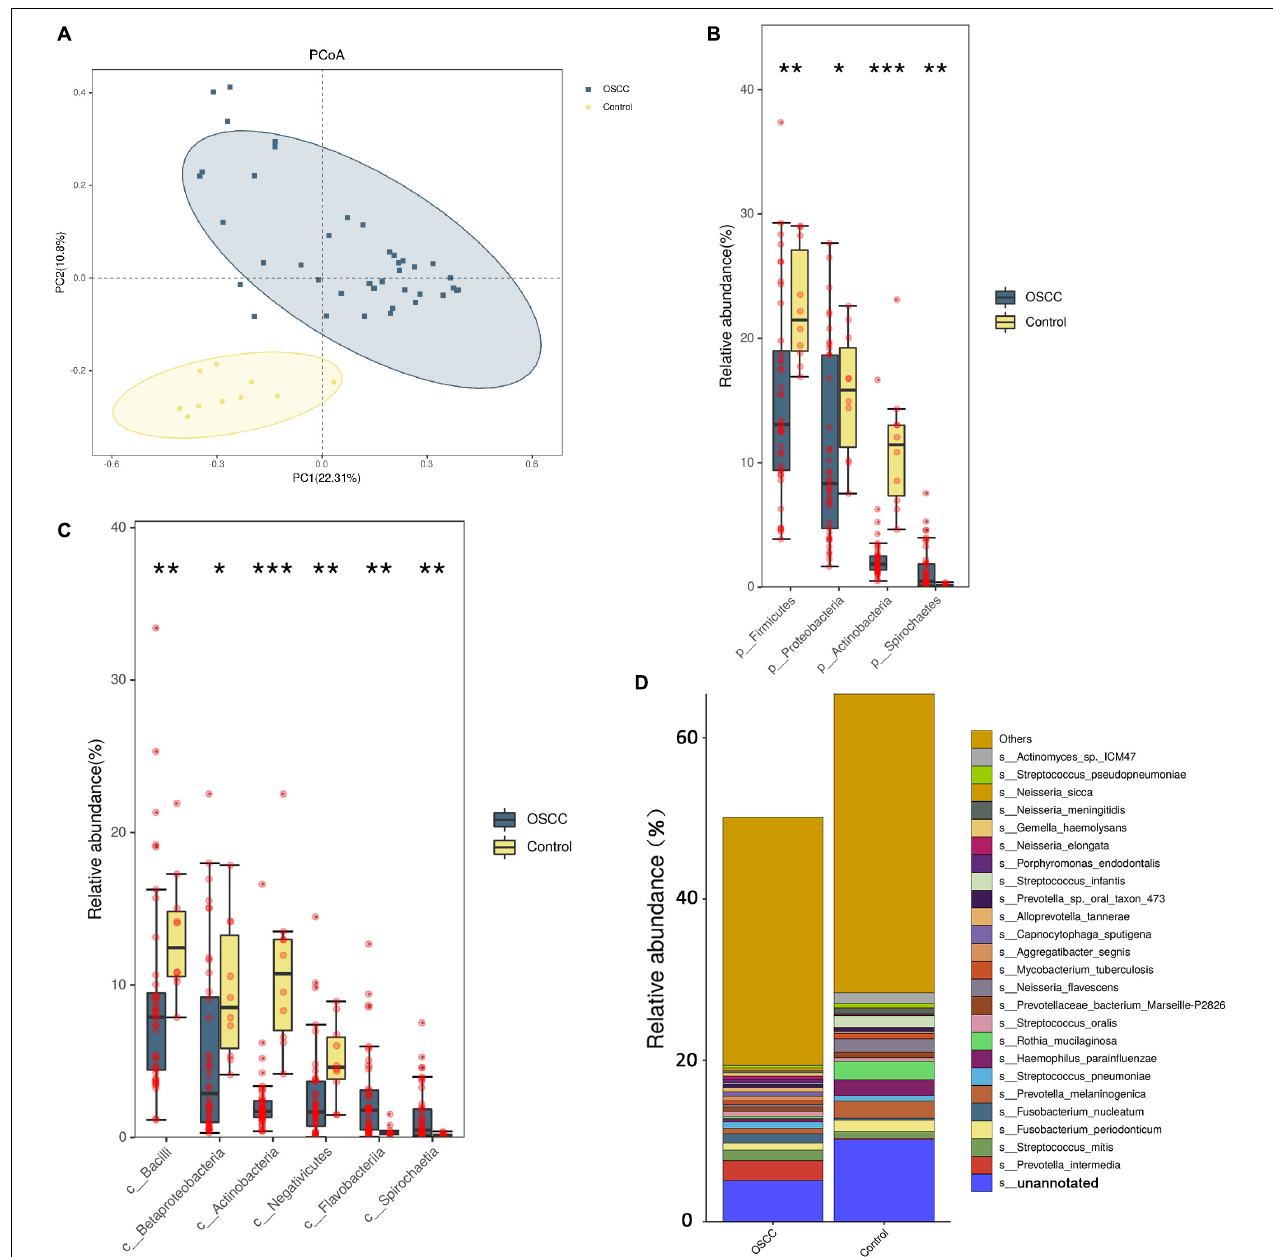
FIGURE 1 | Microbial diversity between the patient group and the healthy control group. (A) PCoA was done on Bray-Curtis distances displaying β -diversity of the microbiome between the patients and controls. The x - and y -axes represent the first and second principal coordinates, respectively, and the proportion of variance. (B,C) At the phylum and class levels, the bacteria changed significantly. (D) Comparing the two groups, the cumulative graph shows 24 species with significant changes. Because the results of metagenomics included bacteria, fungi, and archaea, the total abundance of bacteria was less than 100%. The designation s_unannotated indicates that the species information cannot be matched through the NCBI database (using Wilcoxon non-parametric tests, * p < 0.05, ** p < 0.01, *** p <